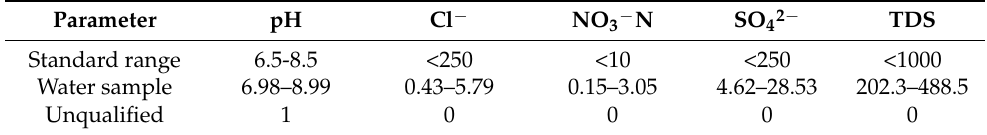
Table 4. Water quality determination (mg · L − 1